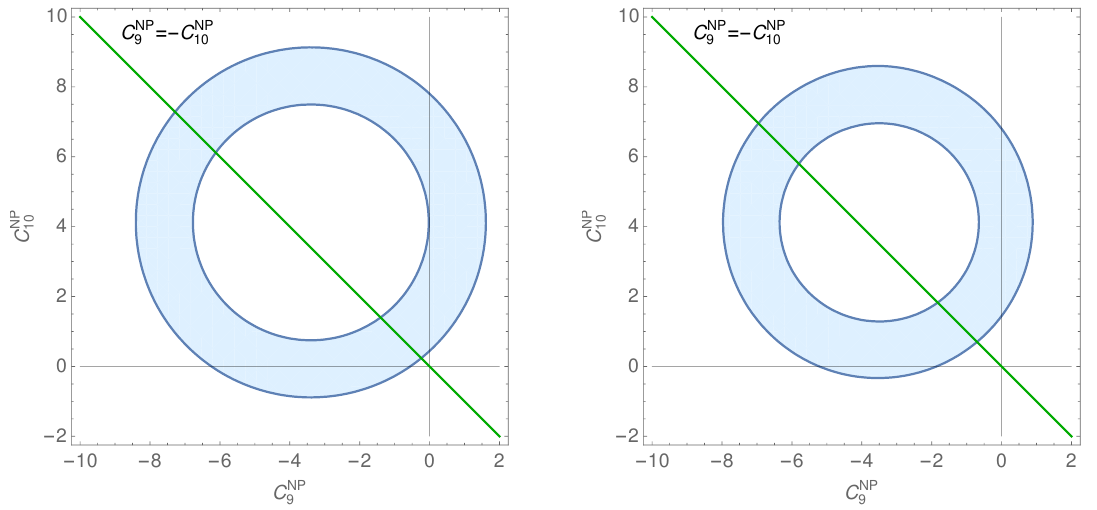
Figure 1 . Estimated 1 (cid:27) -regions of C NP bins (right plot). The green lines correspond to the scenario C NP